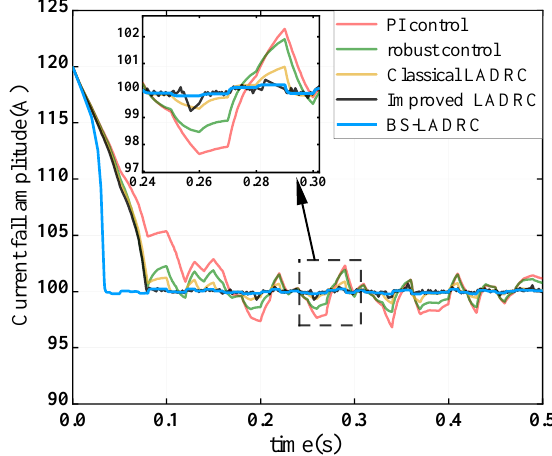
Figure 9. Control antidisturbance performance comparison chart.